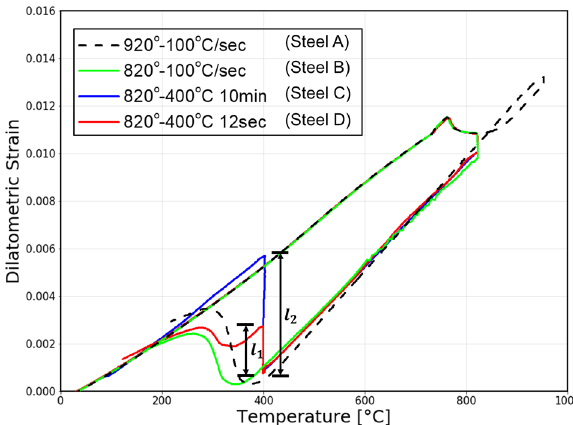
Figure 3. Dilatation curve plot.